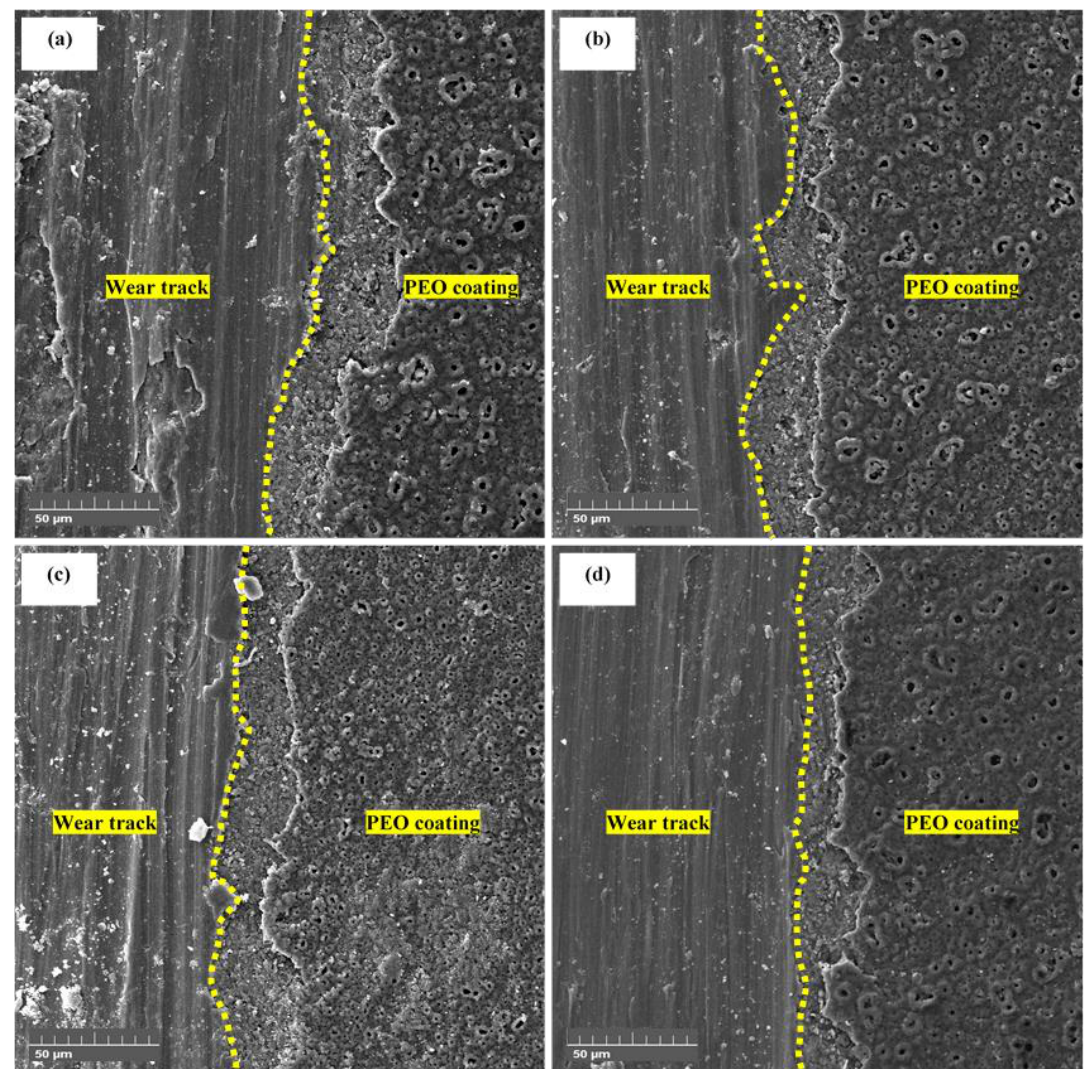
Figure 7. The interface morphology of worn and unworn surfaces of the PEO coatings ( a ) without and with ( b ) 1 g/L, ( c ) 3 g/L, and ( d ) 5 g/L of anatase TiO 2 nanoparticles after the ball-on-disk wear test in SBF solution, viewed at a magnification of 1000×.